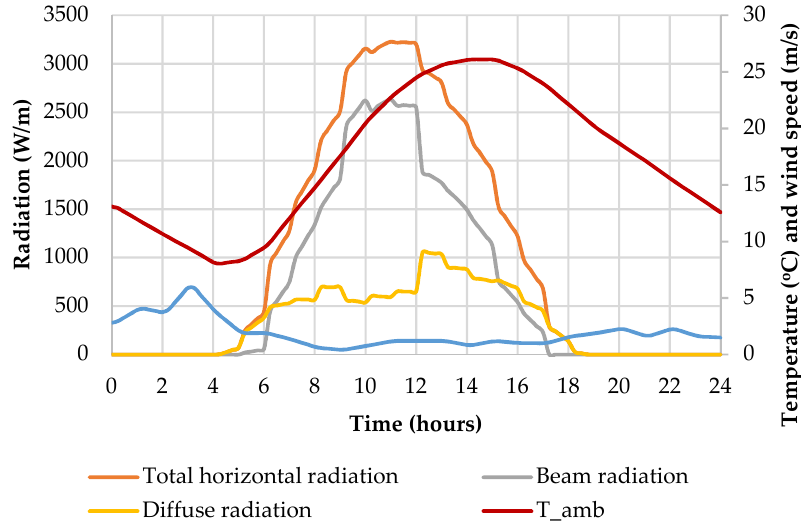
Figure8. MeteorologicaldatafromMeteonorndatabaseforatypicalsummerdayinBucharest,Romania. Energies 2020 , 13 , x FOR PEER REVIEW Figure 8. Meteorological data from Meteonorn database for a typical summer day in Bucharest, Romania.